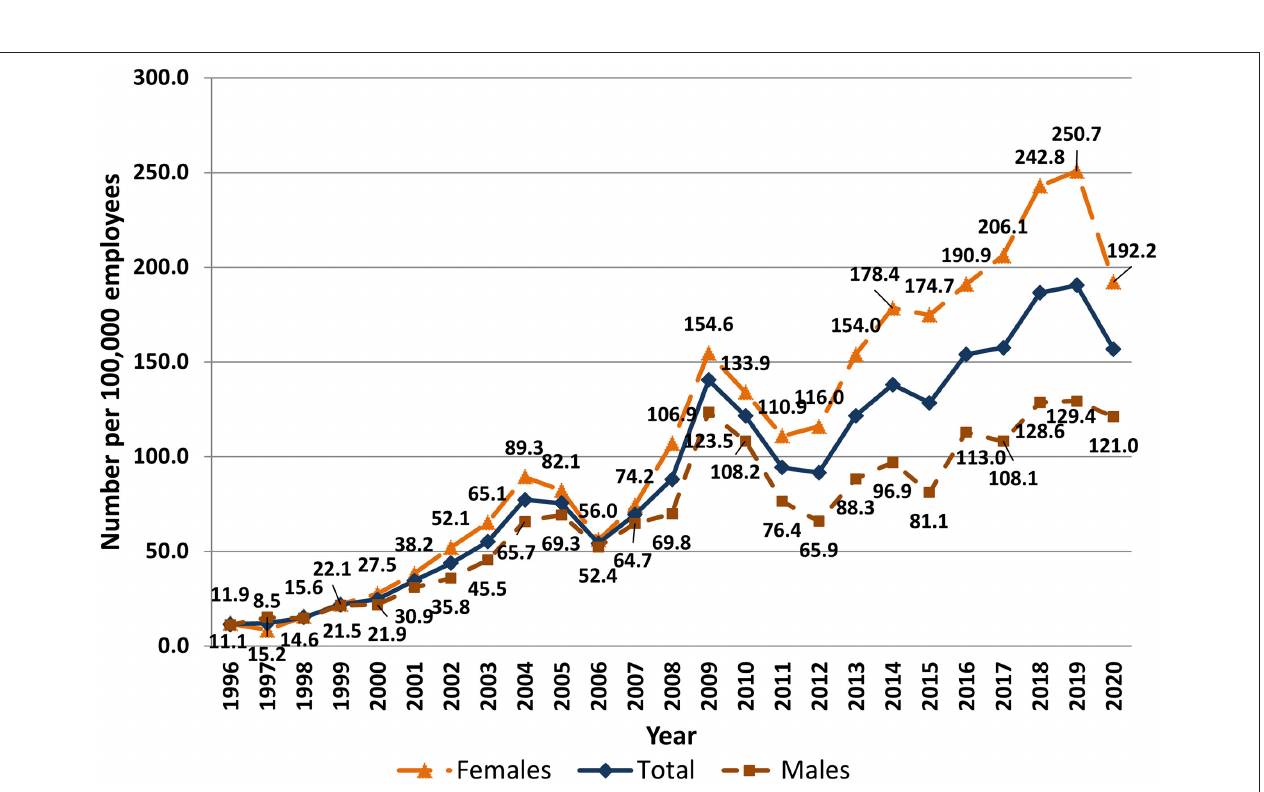
Frontiers in Public Health |